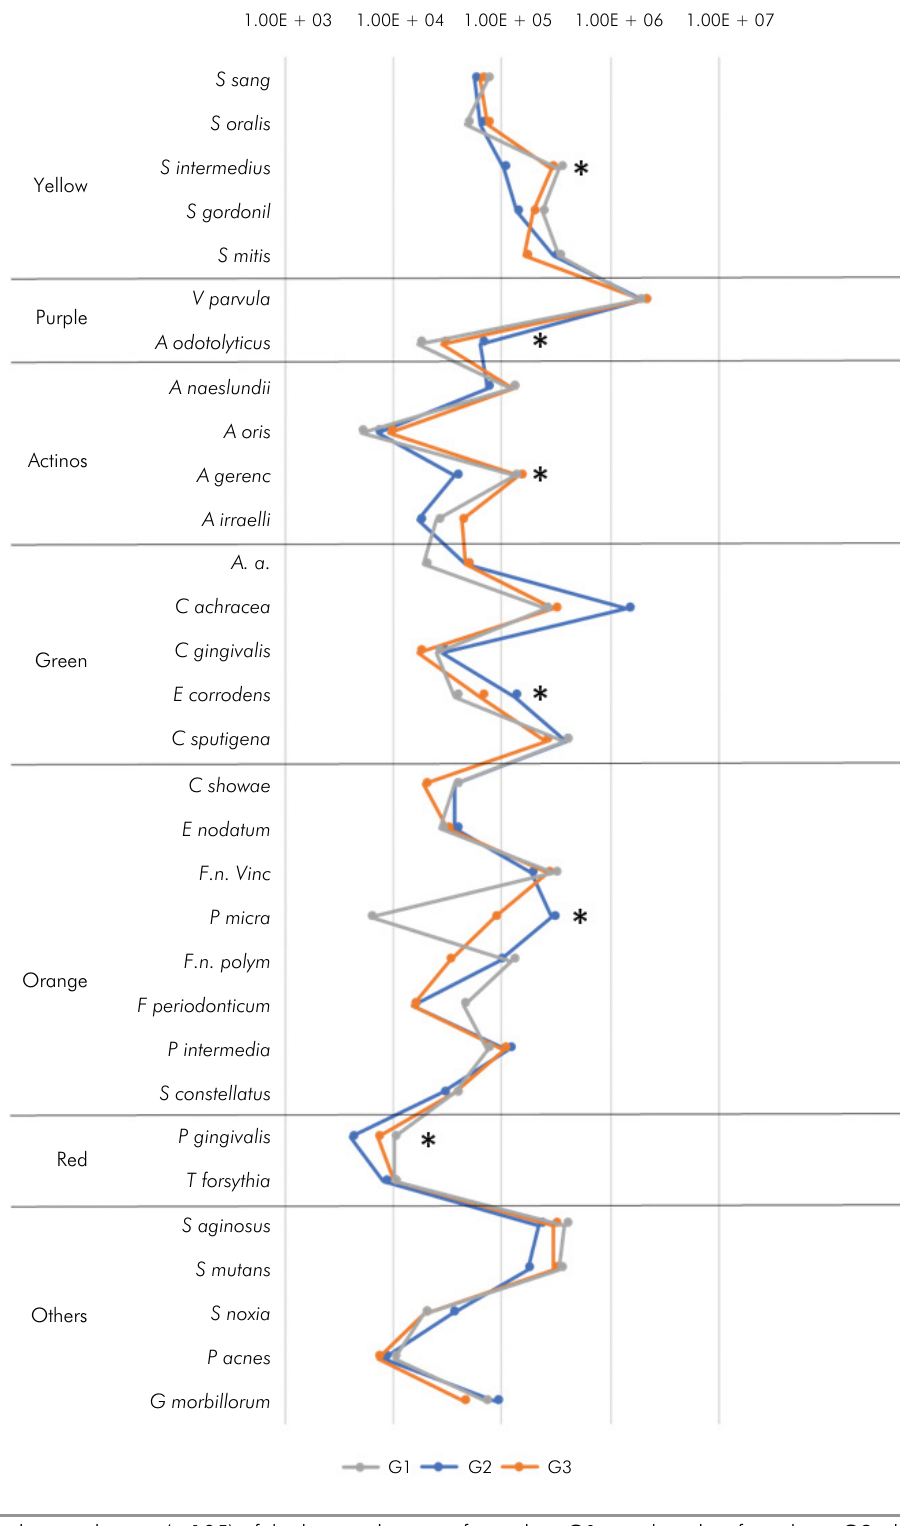
Figure 4. Mean bacterial count (×105) of the bacterial species formed on G1, machined surface discs; G2, discs produced via the additive manufacturing of titanium with chemical treatment; and G3, discs produced via the additive manufacturing of titanium without chemical treatment. Data were analyzed using the Kruskal–Wallis test, followed by Dunnett post hoc analysis.* indicates significant difference between G1 and G2 (p <